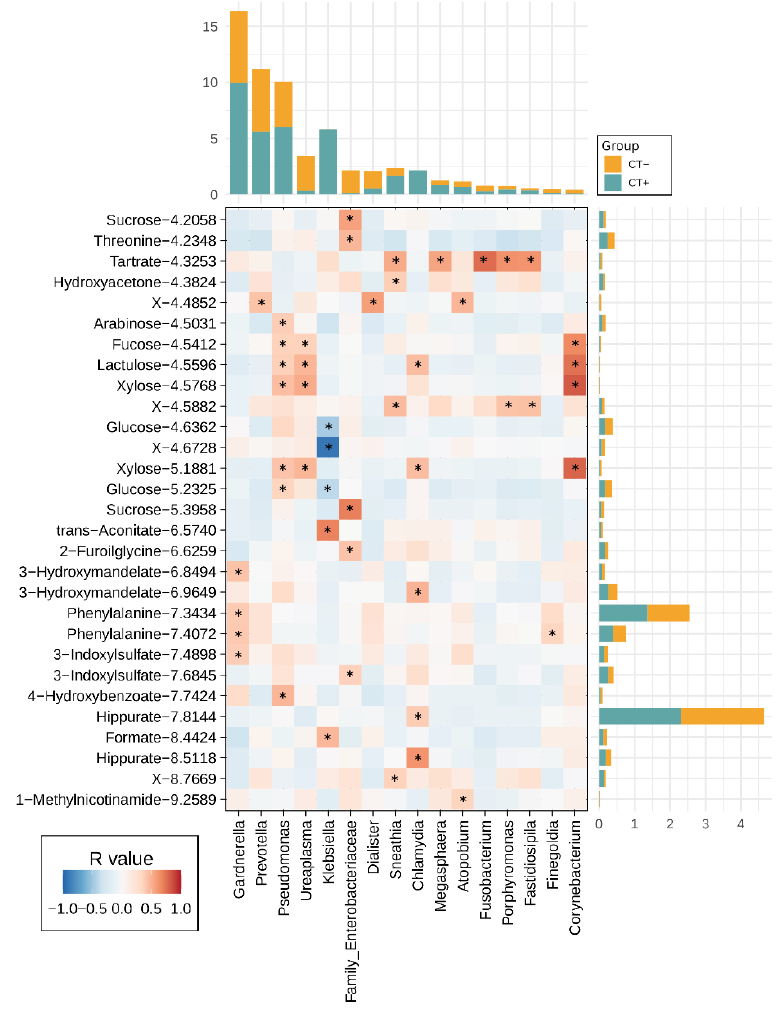
Figure 3. Correlation between the genus abundances and metabolic compounds. Heatmap reporting the positive (red) and negative (blue) Pearson correlations between bacterial groups (at the genus level, with corresponding relative abundances stacked on top, for both patient groups) and the metabolites identified through the 1 H-NMR analysis (abundances stacked on the right). Asterisks indicate statistically significant correlations (asymptotic p -value < 0.05). Only genera and metabolites with at least one significant correlation are reported in the heatmap, i.e., 16 genera and 29 metabolites.